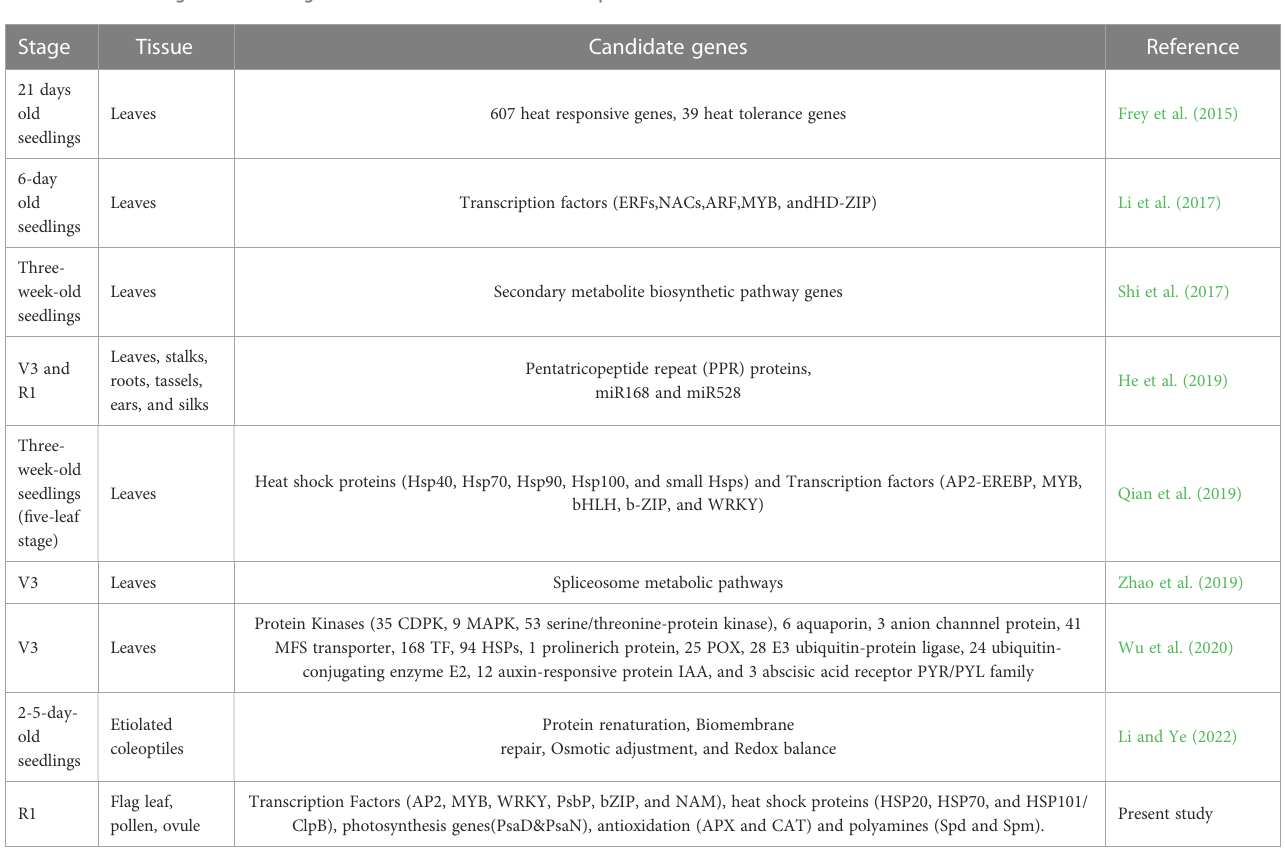
TABLE 5 Candidate genes conferring heat stress tolerance identi fi ed in previous studies in